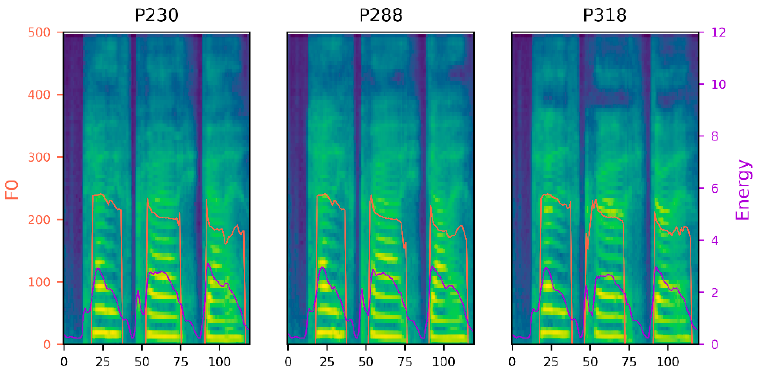
Figure 4. Given the same pitch, energy, and duration information, input different speaker embeddings to synthesize speech.